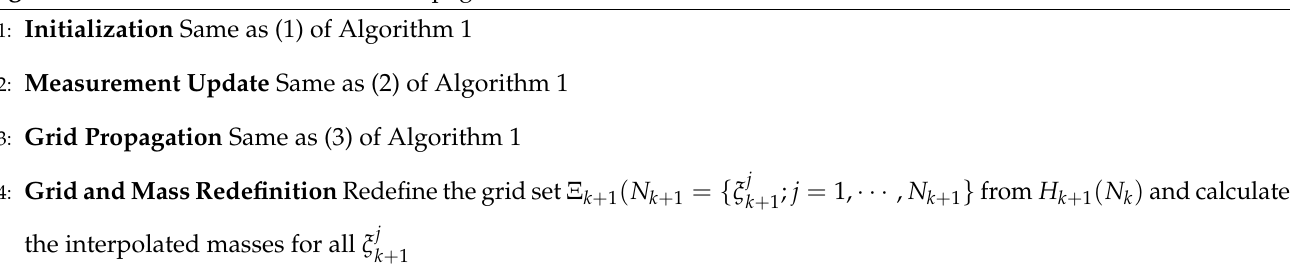
Algorithm 2 PMF with Indirect Time